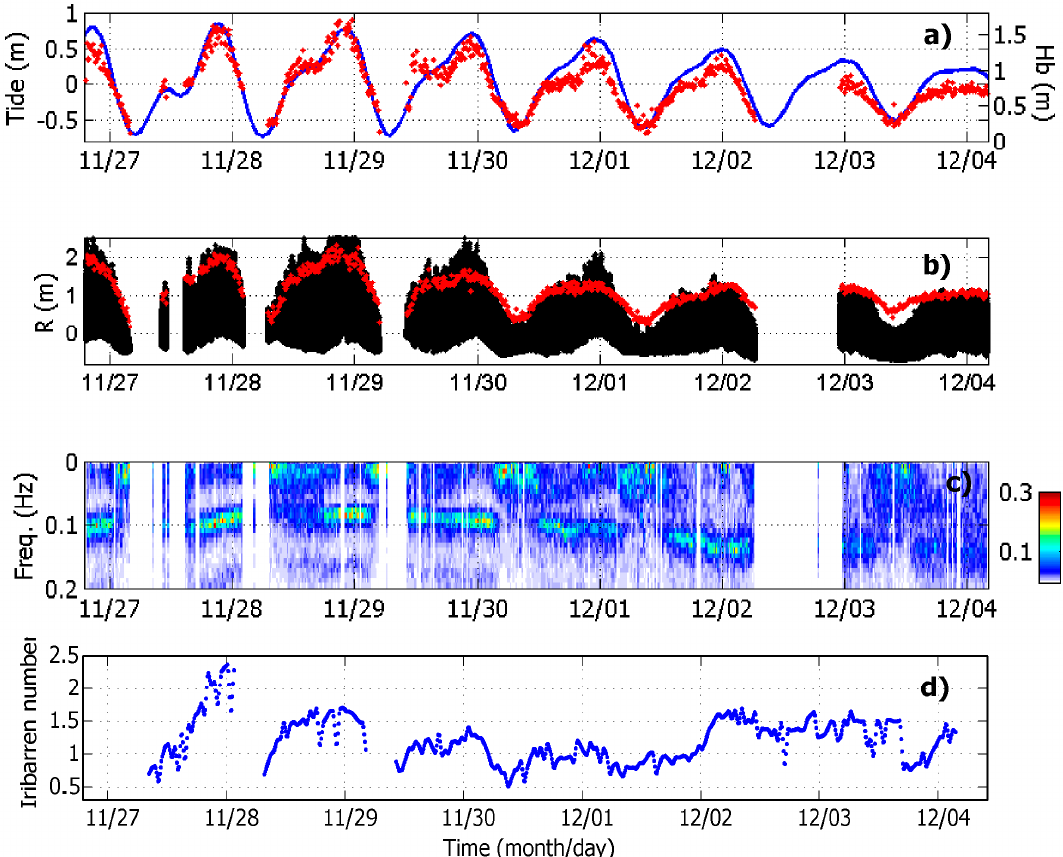
Figure 5. ( a ) Time series of ( a ) H sLIDAR measured on the lower foreshore using the Lidar (red dots) with the overlap of measured tide (blue line); ( b ) raw vertical run-up observations (black dots) and significant vertical run-up (red dots); ( c ) normalized wave spectra measured on the lower foreshore, and; ( d ) Iribarren number (blue dots).